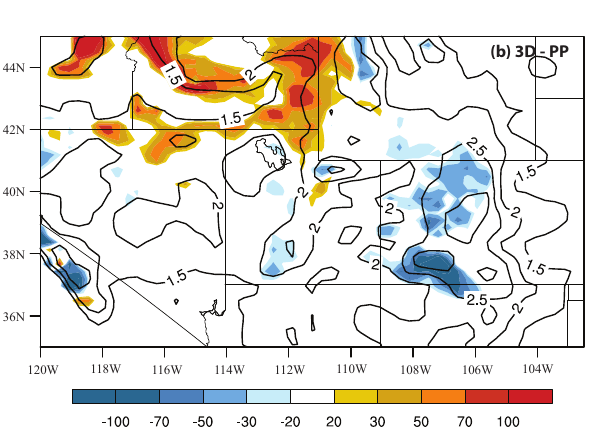
Figure 3. The April mean (a) SWE (mm) and (b) corresponding differences